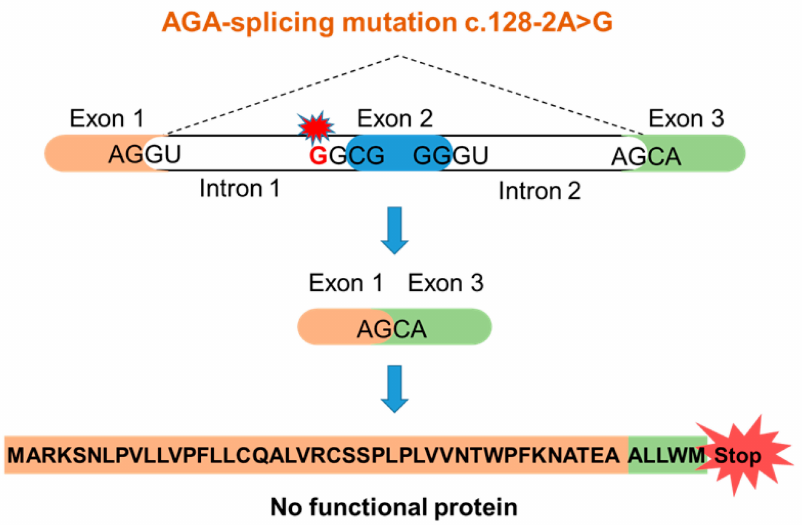
Figure 1. Predicted consequences of the c.128-2A>G AGU